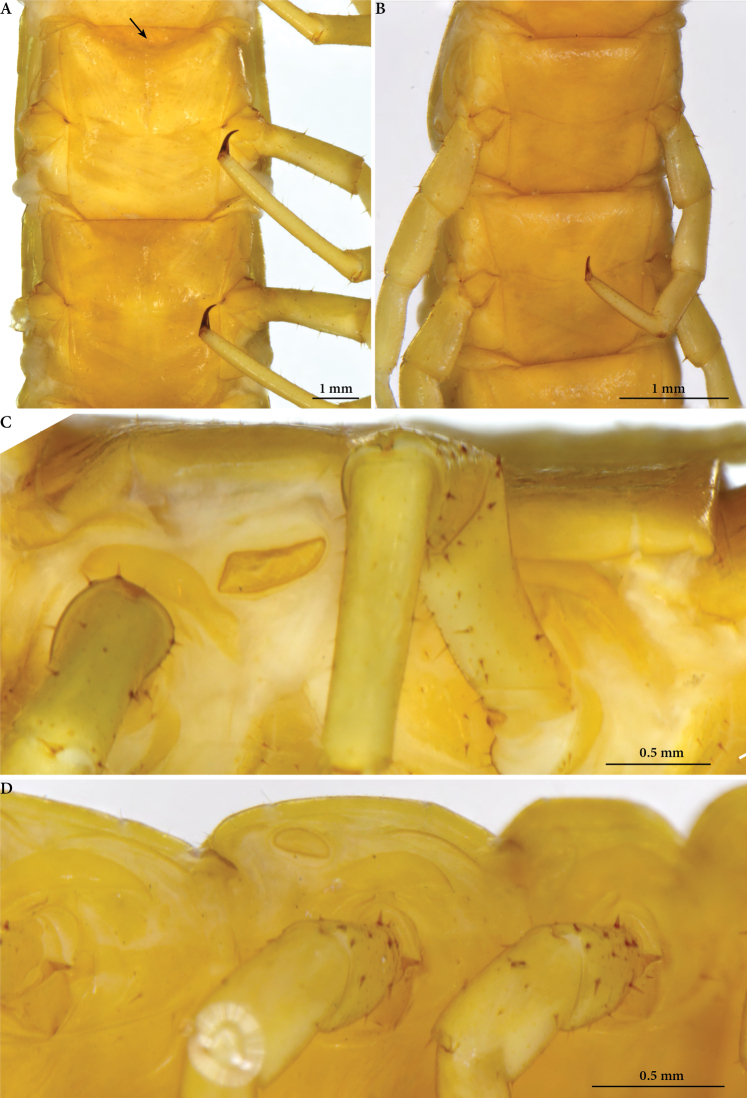
Cryptops spp., sternites 8–9 and spiracles A, B sternites 8–9 ACryptops
speleorex sp. nov., holotype, arrow indicating the endosternite BCryptops
anomalans, Pirin Mts (Bulgaria) C, D spiracles CCryptops
speleorex sp. nov., holotype DCryptops
anomalans, Pirin Mts (Bulgaria).